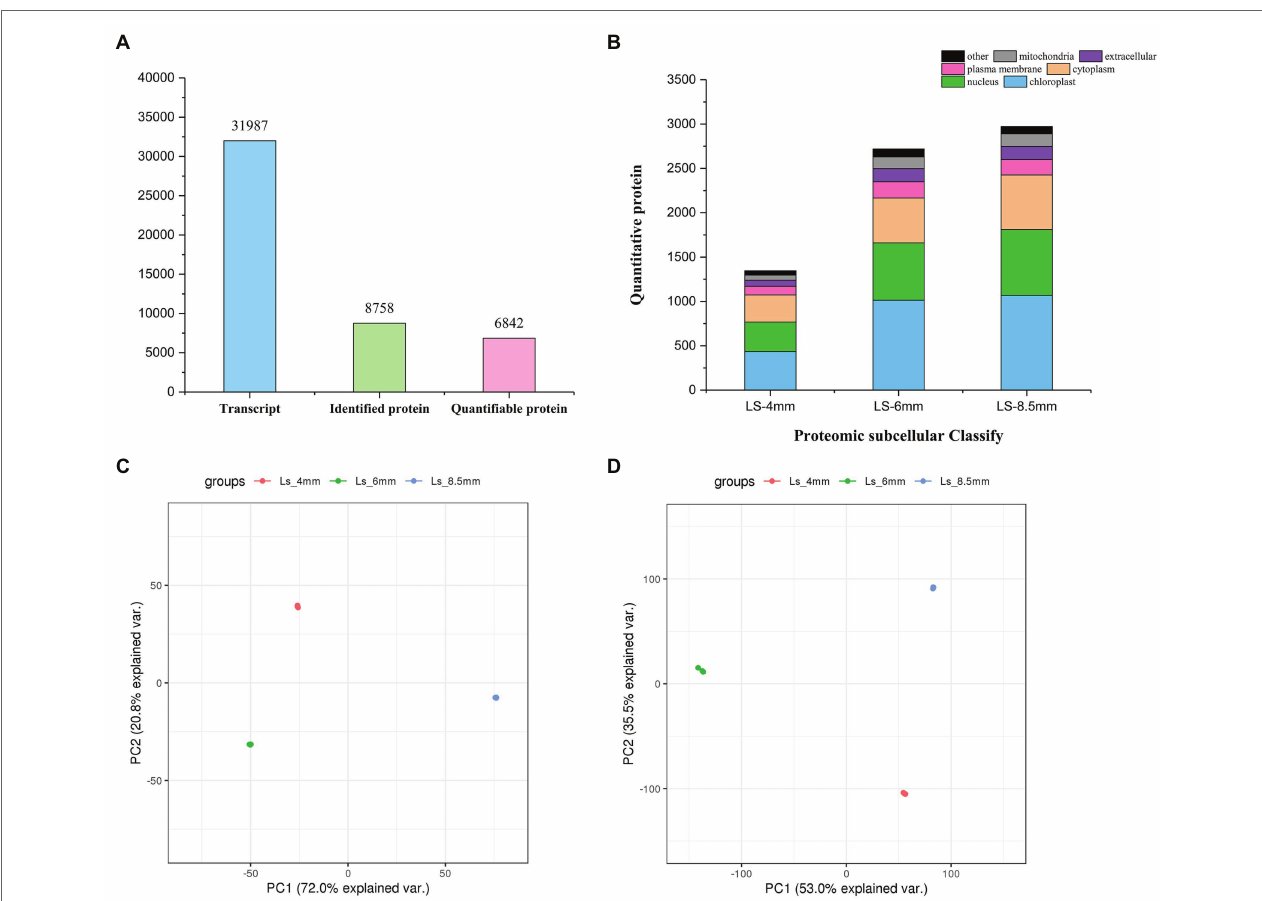
FIGURE 4 | Transcriptomics and proteomics in O. longistaminata pollen. (A) Number of mRNAs/proteins detected in the RNA-seq/proteome analysis. (B) Number of proteins with different subcellular localizations. (C) PCA plot showing the quantitative repeatability of the transcriptome. (D) PCA plot showing the quantitative repeatability of the